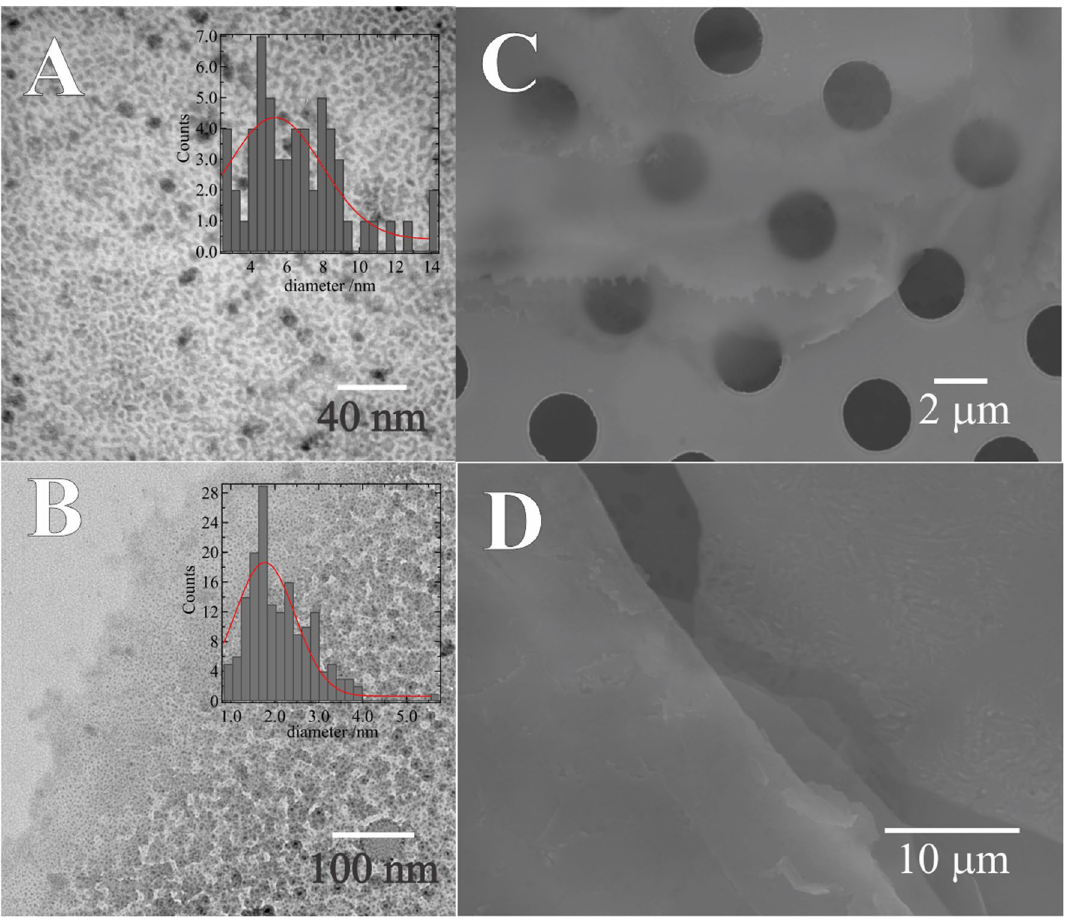
Figure 3. TEM micrographs obtained for aqueous phase samples after 25 consecutive CV scans using Cell 1 at a w|DCE interface with [CuSO 4 ] = 5 mM, as well as 5 ( A ) and 20 mM ( B ) of TT in DCE and deposited on a 2 µm diameter holey Au TEM grid; inset are histograms of Cu NP/nanocluster sizes. ( C ) SEM micrograph of the sample shown in B. ( D ) SEM image of the film generated at a large ITIES using Cell 2 with 5 mM of CuSO 4 (aq) and 20 mM of